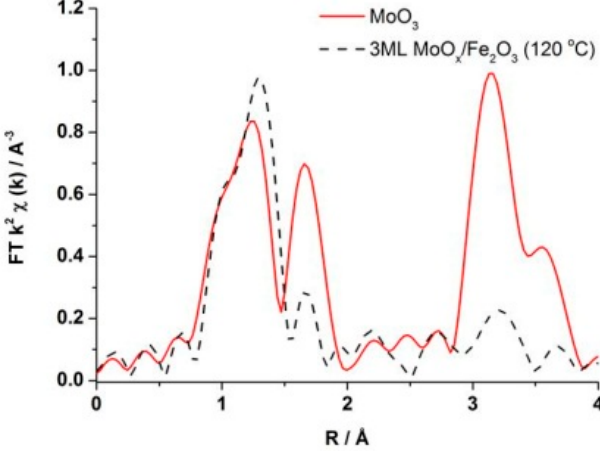
Figure 6. Fourier transform (non phase ‐ corrected) for 3ML MoO x /Fe 2 O 3 (120 °C) and MoO 3 . Image adapted from C. Brookes et al. ACS Catal. , 2014 , 4 (1), pp. 243–250 [16].